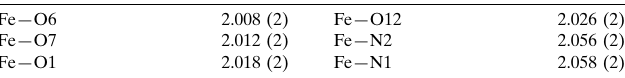
Selected geometric parameters (A˚ , (cid:2) ).